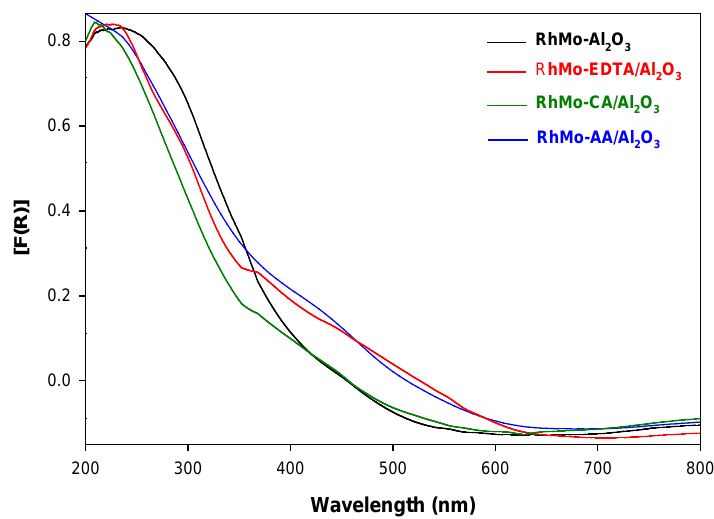
Figure 1. UV-vis spectra of RhMo/Al 2 O 3 and RhMo-x/ γ -Al 2 O 3 (x = EDTA, AA, CA) catalysts.